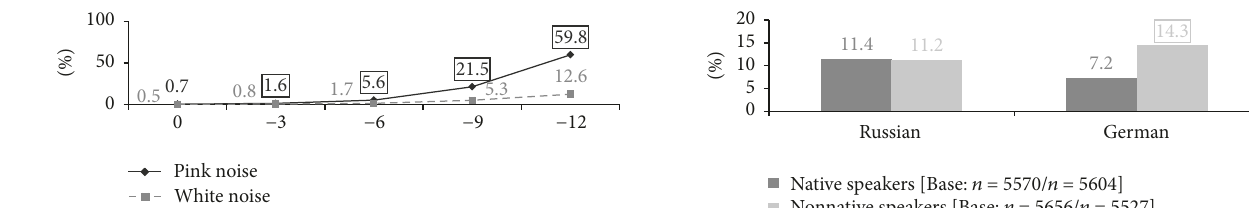
Figure 3: Utterance miss (false negative error) for listeners, who are native Russian speakers, depending on the characteristics of the speaker.